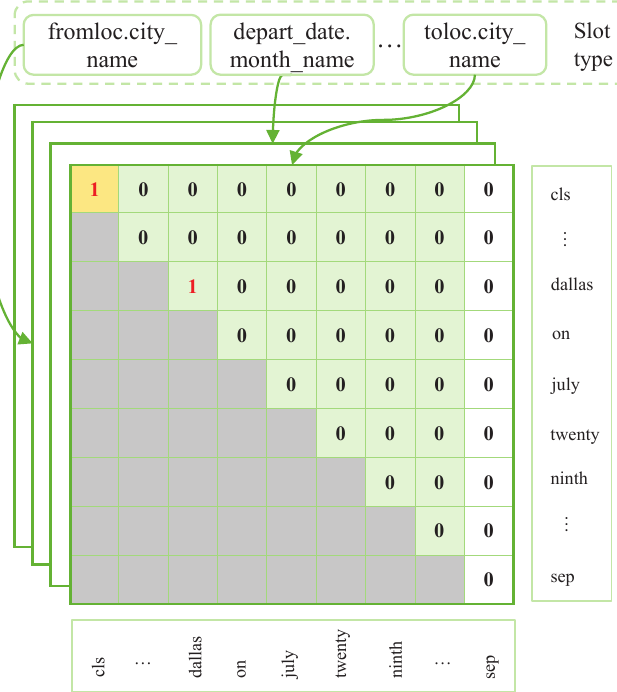
Figure 3. Illustrations of multi-dimensional type-slot label interaction network. Each element corresponds to a word pair. The gray, yellow, and green sections represent the lower triangle mask, type pointer, and slot tail pointer, respectively. The red number “1” indicates the type pointer or slot tail pointer at the corresponding